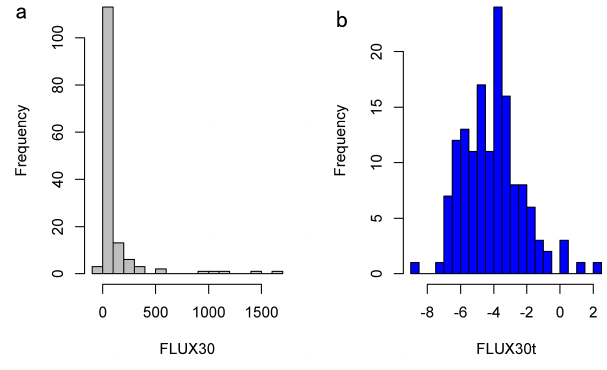
Figure 3. Histograms of (a) the original N 2 O fluxes (FLUX30) and (b) the logit-transformed N 2 O fluxes